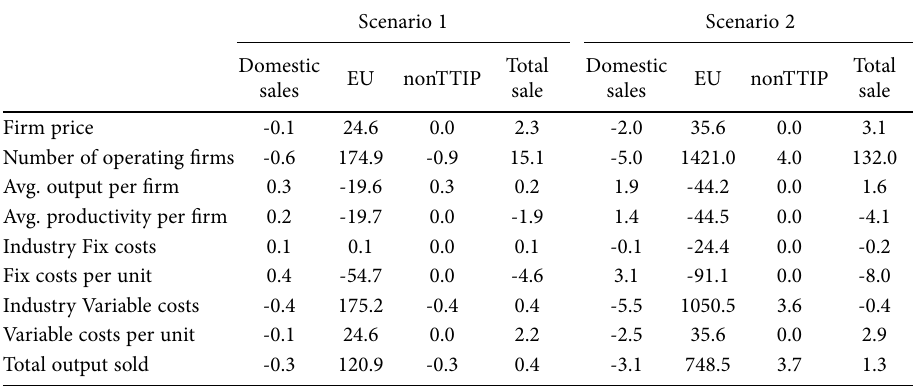
Table 8. Average firm results for US domestic sales and exports of processed food [%